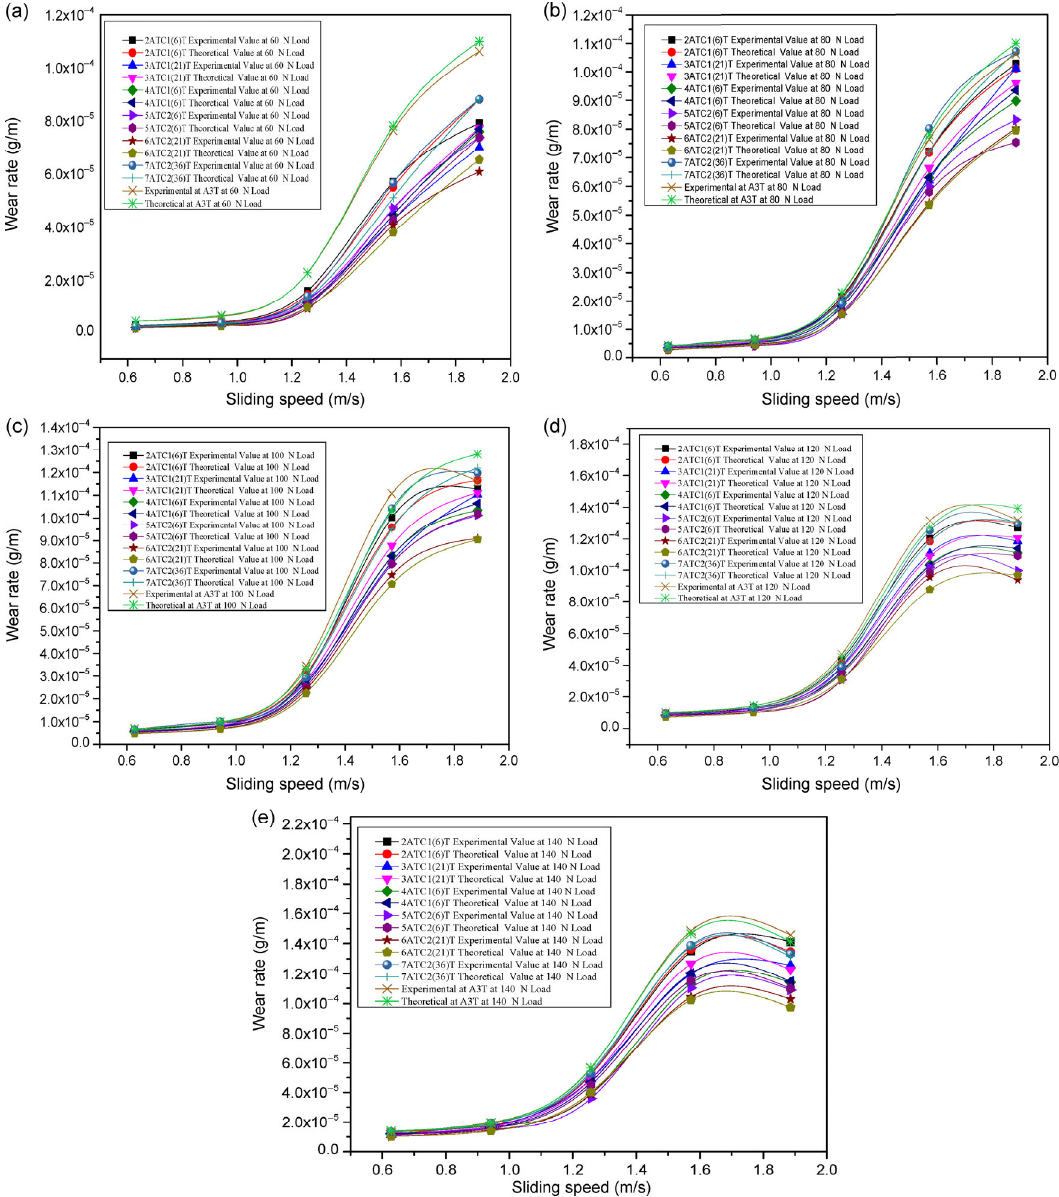
Fig. 8 Comparison of theoratical and experimental results for W R at varying sliding speeds and loads: (a) 60 N, (b) 80 N, (c) 100 N, (d) 120 N, and (e) 140 N in the case of varied treatments: A3T, ATC1(6)T, ATC1(21)T, ATC1(36)T, ATC2(6)T, ATC2(21)T, and